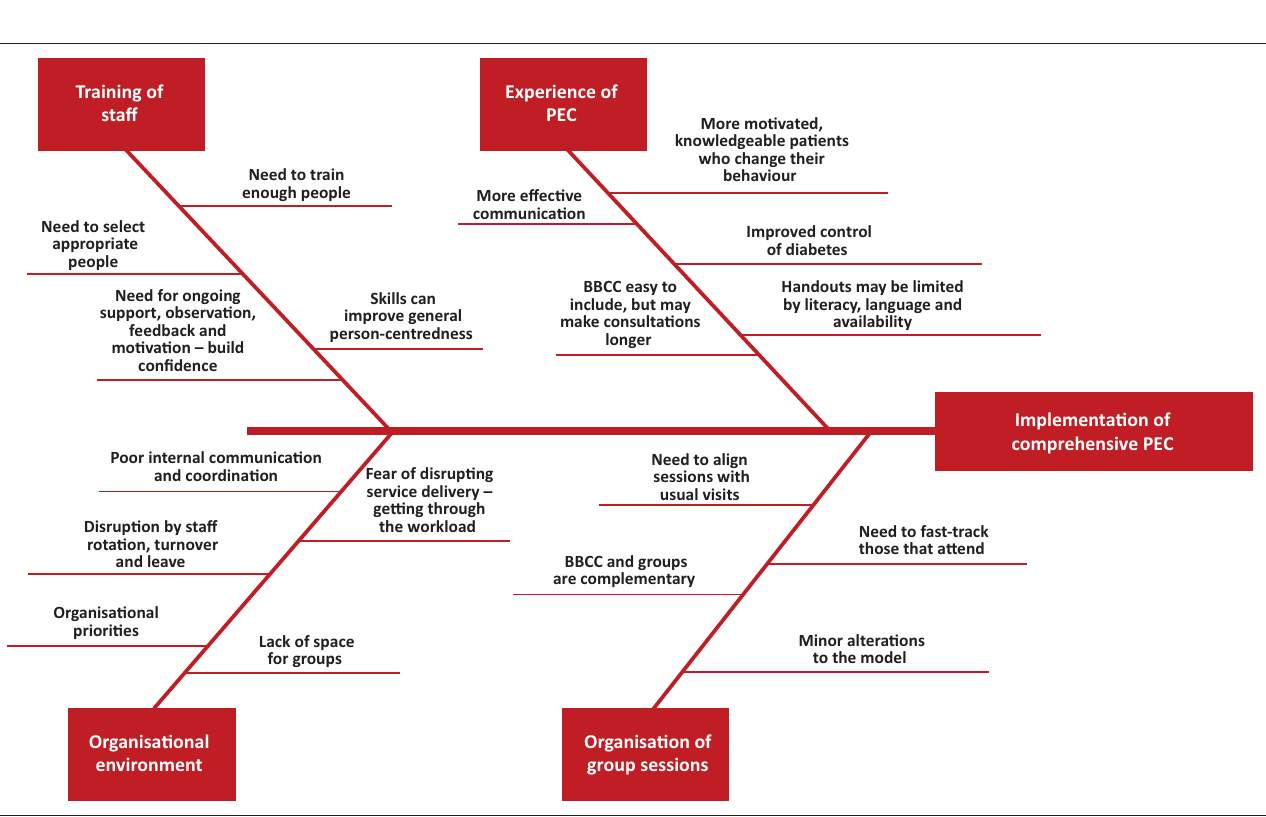
FIGURE 1: Summary of key